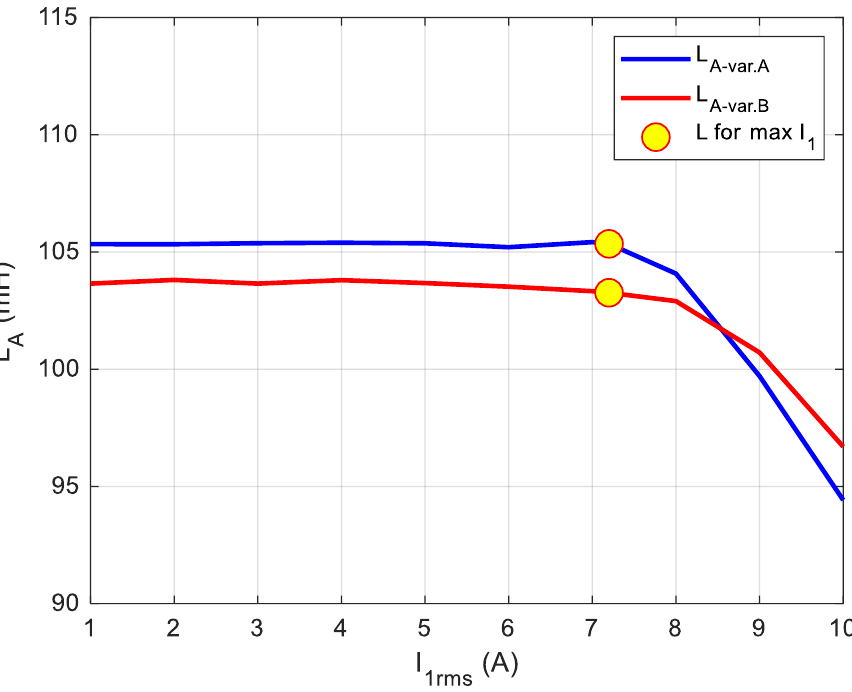
Figure 12. Operational inductances depending on the input current.